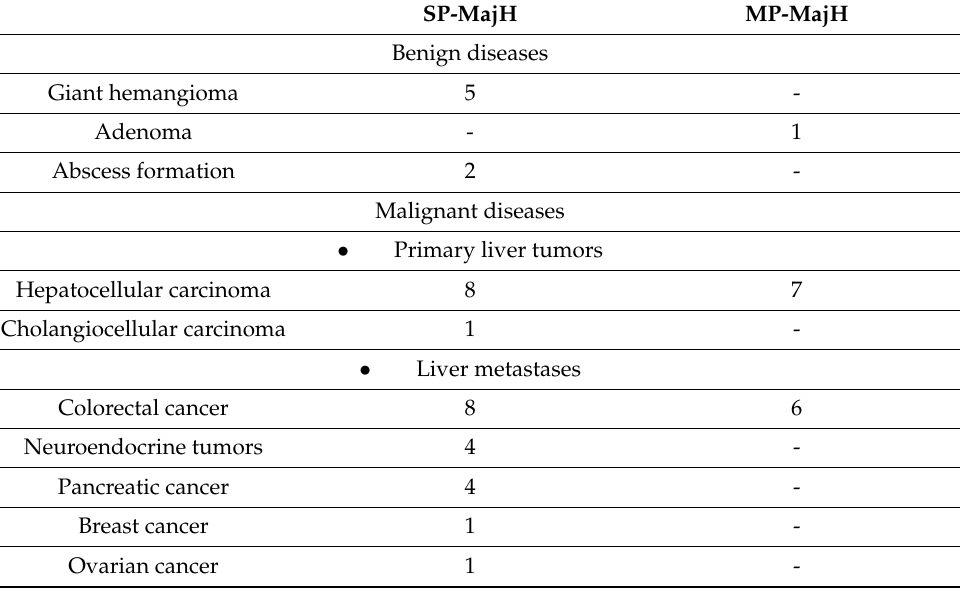
Table 3. Underlying